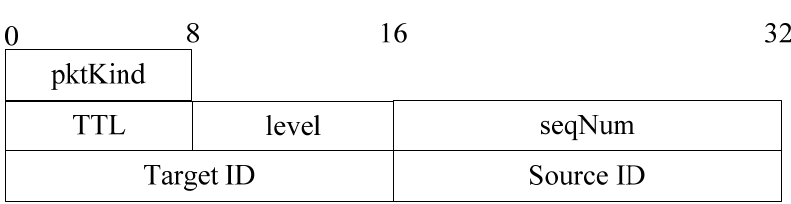
Figure 9. Format of level back